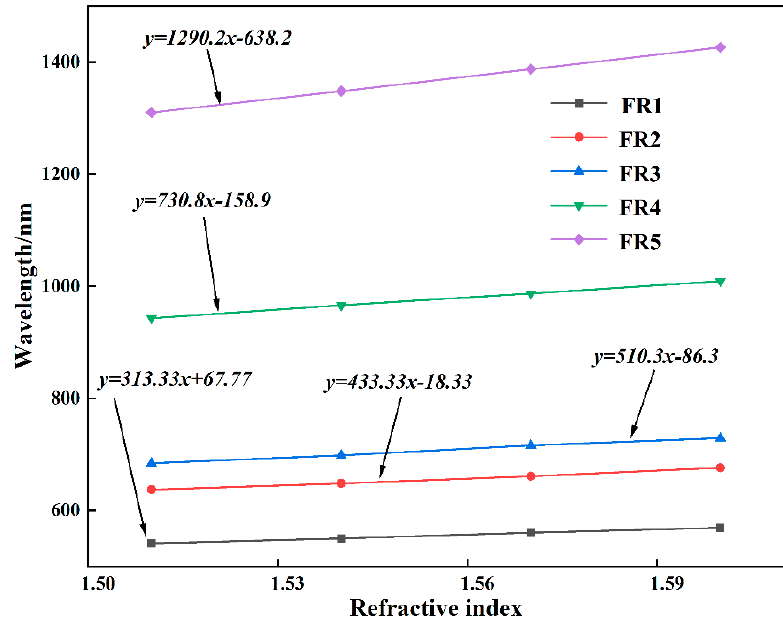
Figure 8. Refractive index sensing sensitivity of fivefold Fano resonances. Table 2. Comparison of the sensitivity with other references.